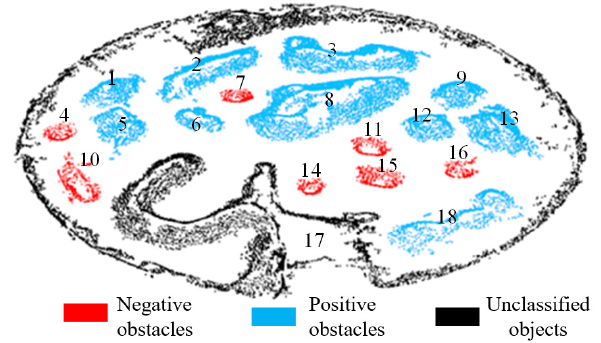
Figure 17. Obstacle recognition result of the 3D mapping dataset.